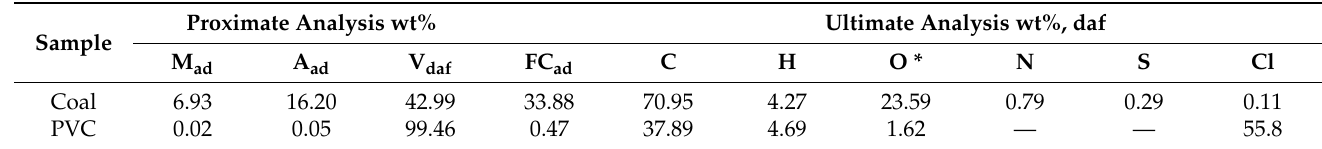
Table 1. Proximate and ultimate analyses of the coal sample and PVC.